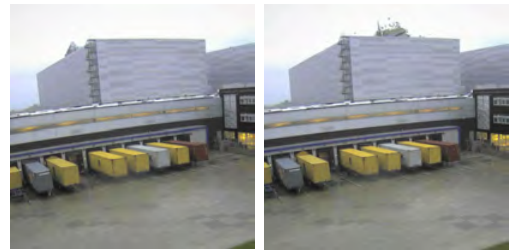
Figure 2. Pictures from a security camera taken during the storm in 2013, the roof failure is visible.